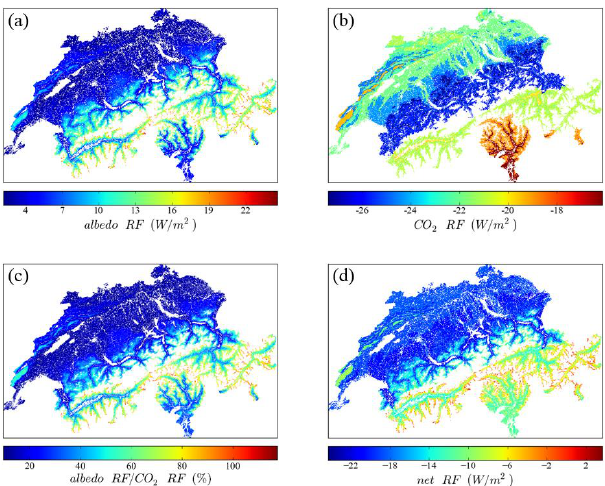
Figure 4. (a) Albedo RF, (b) CO 2 RF, (c) offset: albedo RF/CO2 RF and (d) net RF: albedo RF plus CO 2 RF. All data sets were derived for transitions from intensively used open land ( < 1000m) and extensively used open land ( > 1000) to closed forest.